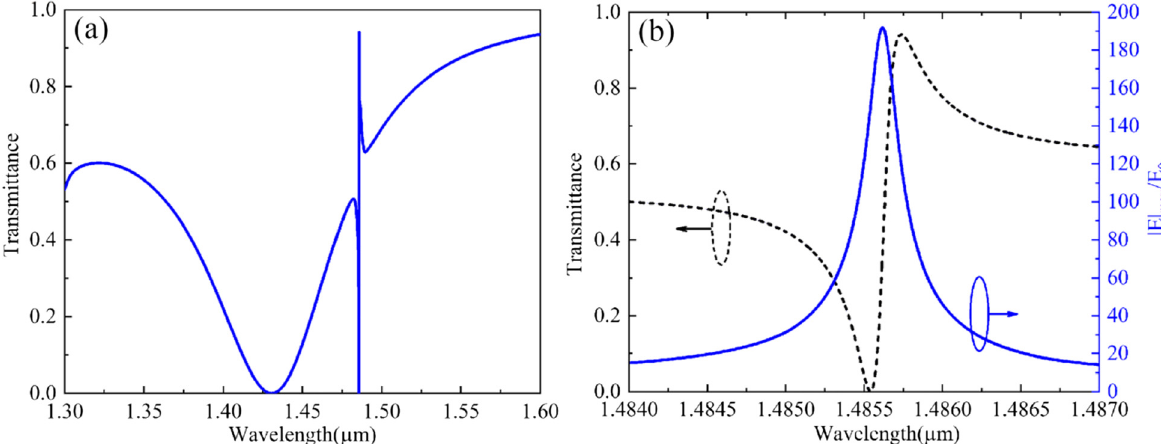
Figure3: (a)TransmissionspectrumthroughtheslottedAlGaAsdiskarraywithalinearlypolarizedplanewaveexcitation;(b)Zoominshowing thesharpresonancein(a),blackdashedline.AlsoplottedinblueisthemaximumofthelocalelectricfieldamplitudeintheAlGaAsdomainas a function of